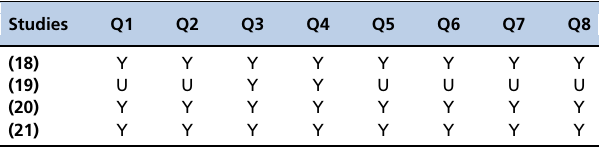
Table 3 - Results of the critical assessment of the included studies (Cross-sectional) using the Joanna Briggs Institute approach.